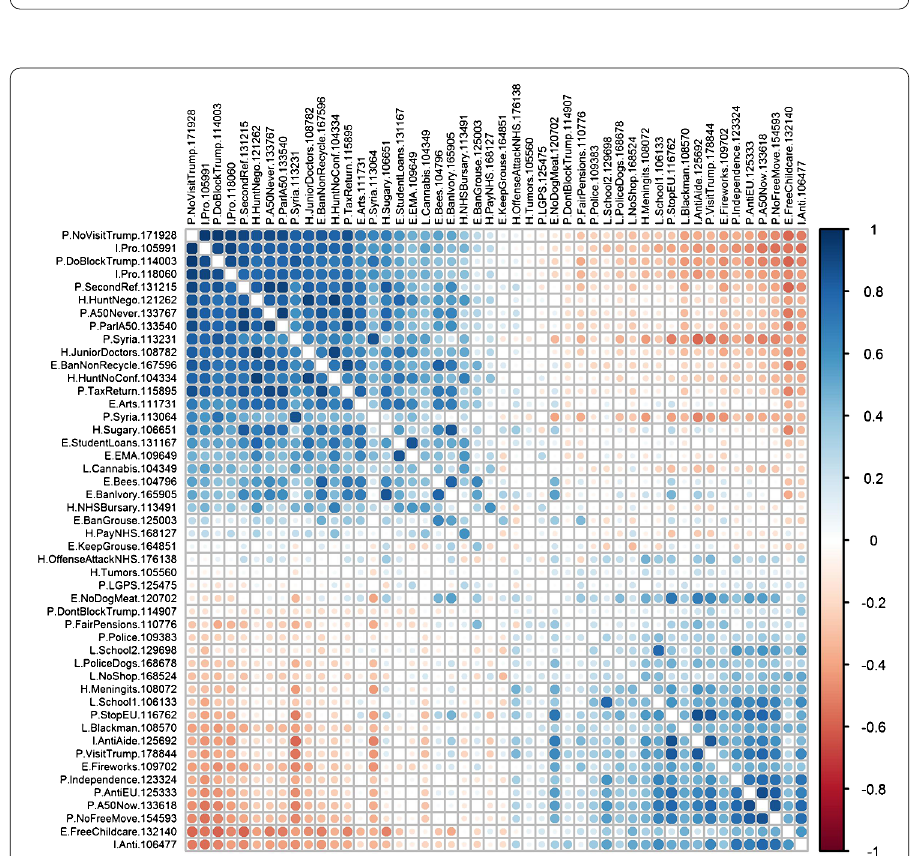
Figure 2 Plot showing the degree of linear correlation between e-petition